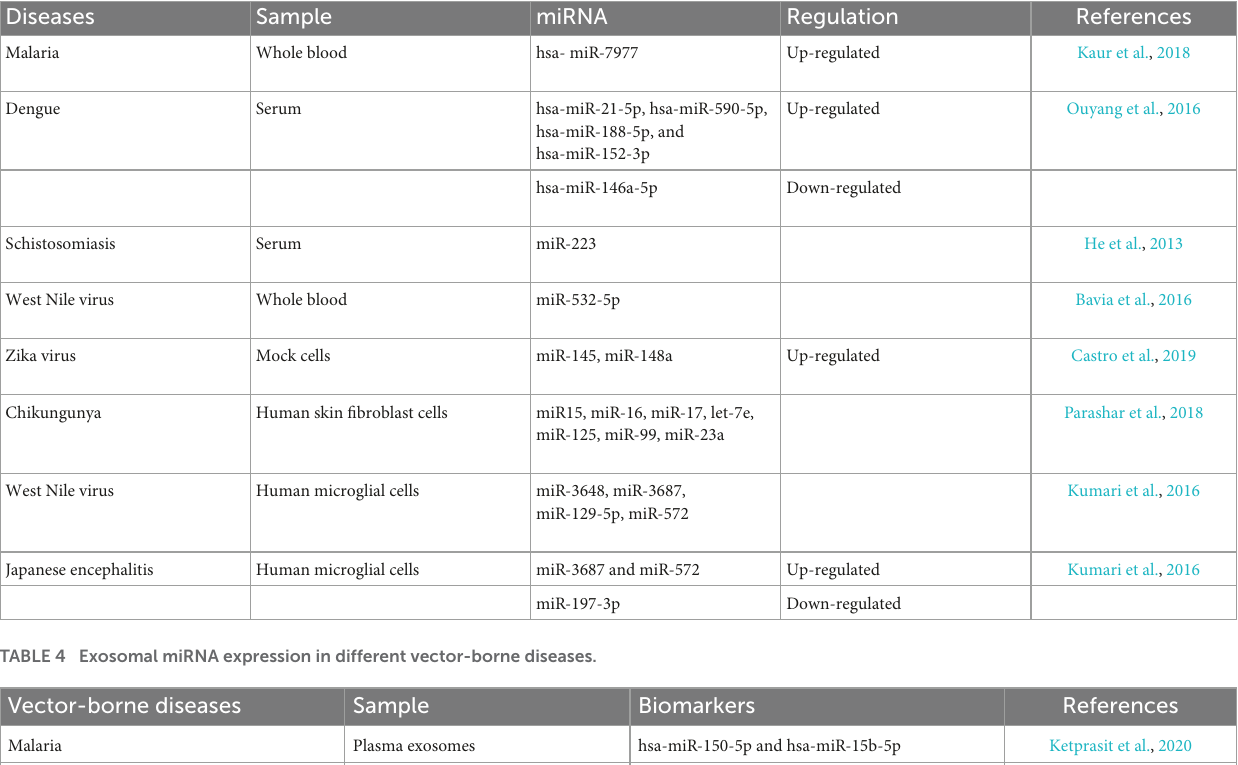
TABLE 3 miRNA biomarker for vector-borne diseases.